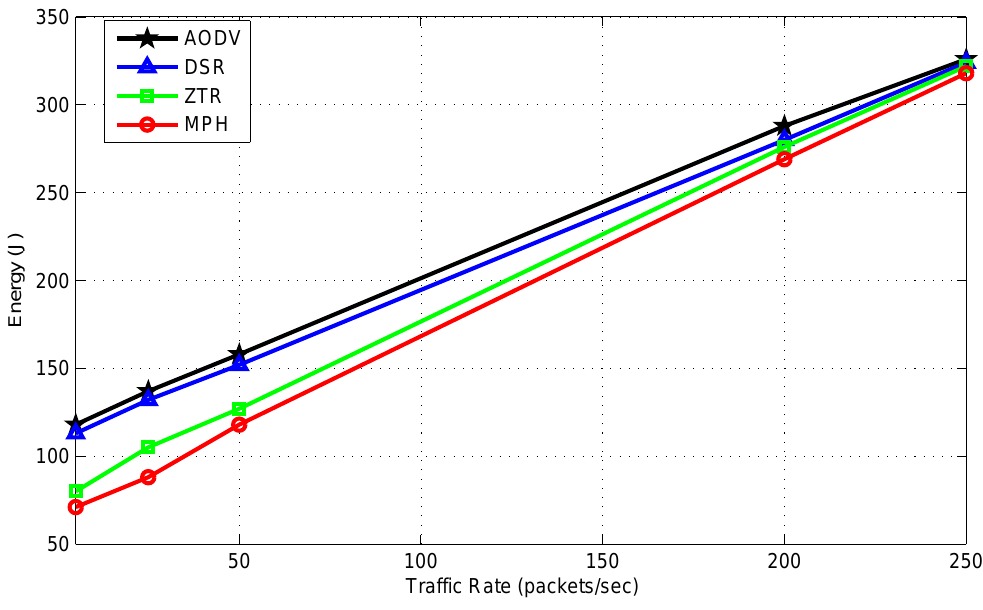
Figure 17. Global energy